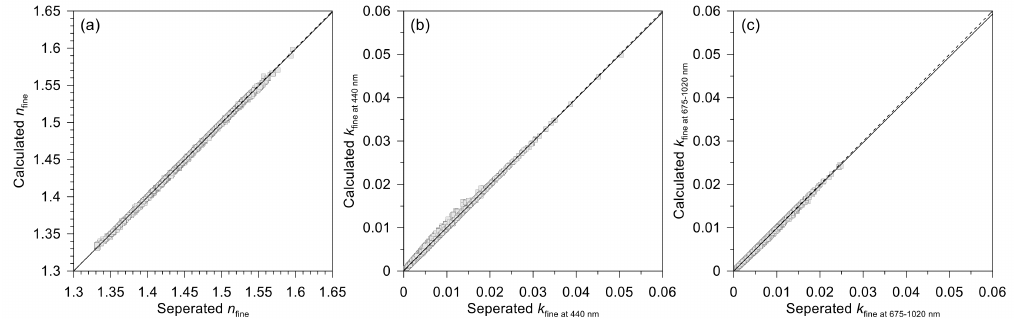
Figure 3. Comparison of calculated and separated fine-mode refractive index from AERONET level 2* (L2*). ( a ) The real part ( n ), and the imaginary part ( k ) ( b ) at 440 nm and ( c ) from 675–1020